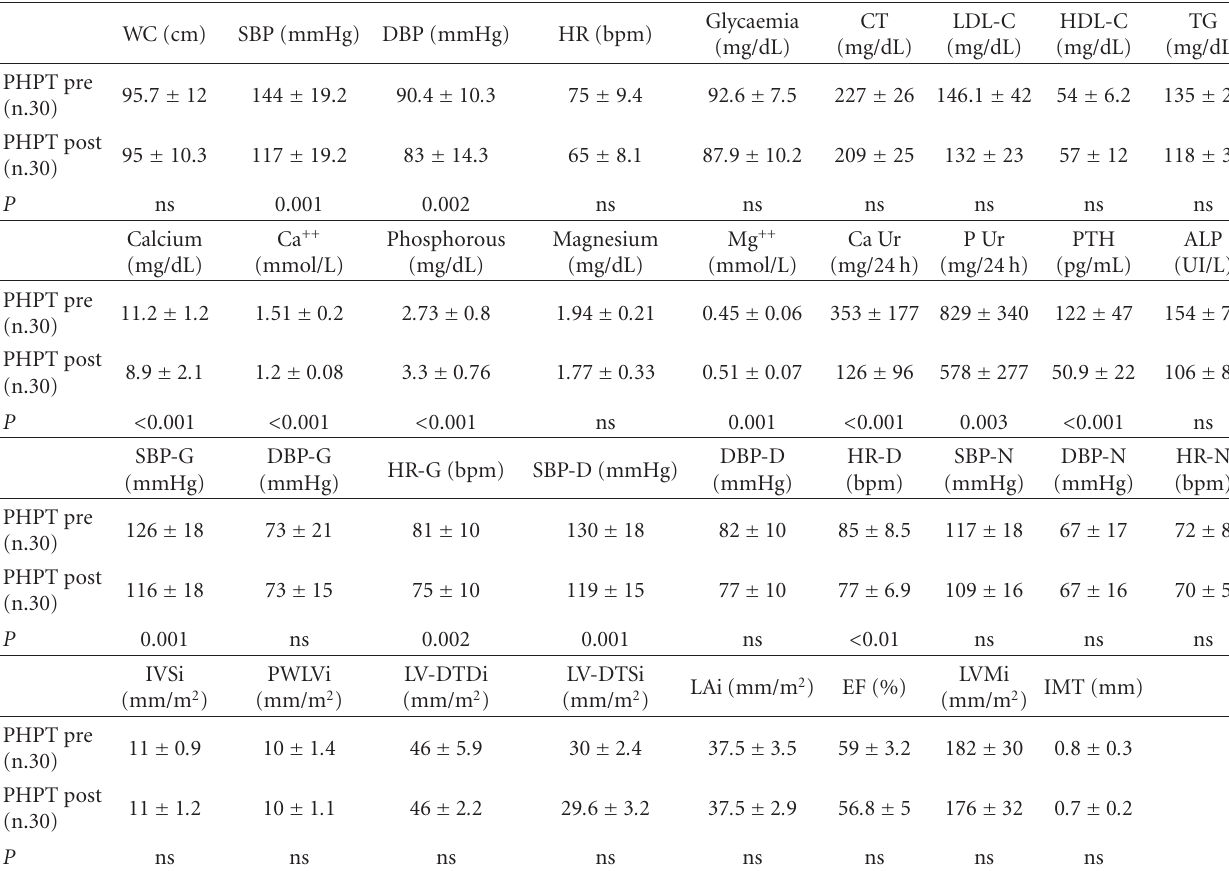
Table 5: Demographic, biochemical, ABPM, echocardiographic, IMT parameters in PHPT patients before (PHPT pre) and after (PHPT post)